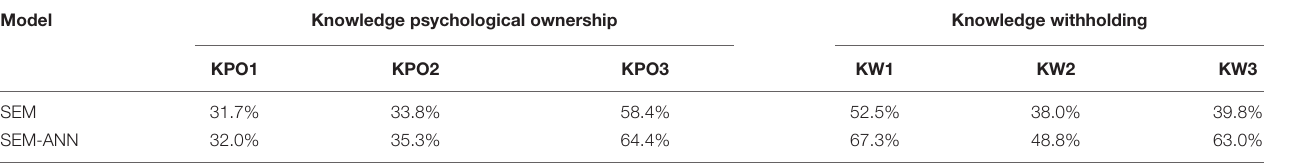
TABLE 6 | Comparison between SEM model and SEM-ANN model.